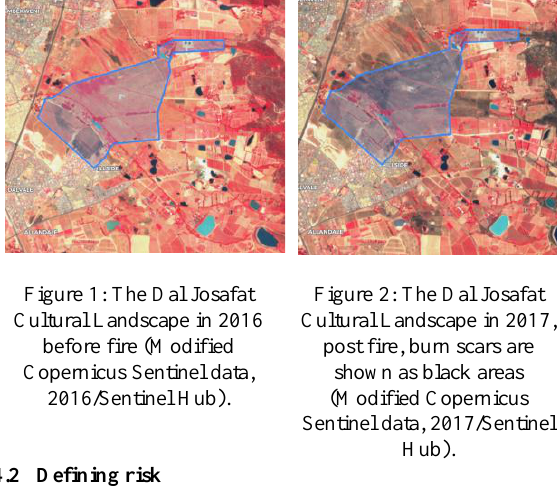
Figure 1: The Dal Josafat Cultural Landscape in 2016 before fire (Modified Copernicus Sentinel data, 2016/Sentinel Hub).